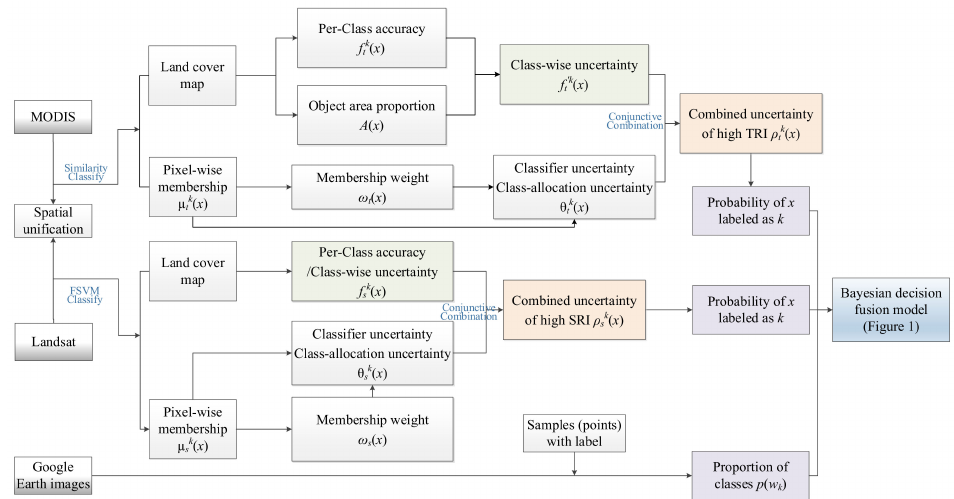
Figure 2. Detailed flow chart of PBF. The process for acquiring the parameters is described.